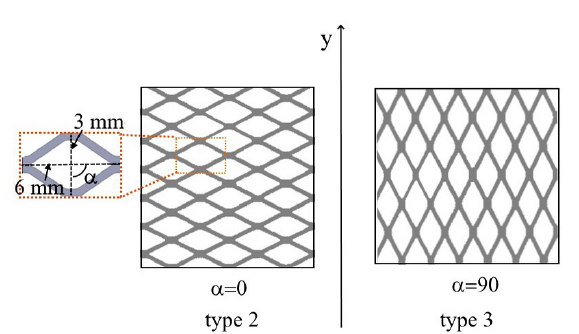
Figure 1: Orientation of reinforcement cells in the aluminum matrix along the y-axis (according to the loading direction). The insert is to show cell